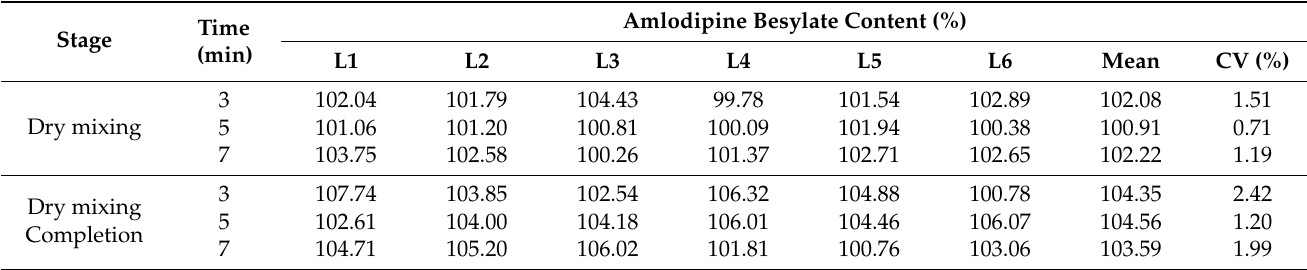
Table 5. Processing time during dry mixing stages of amlodipine besylate layer at different locations (L) in batch 1.